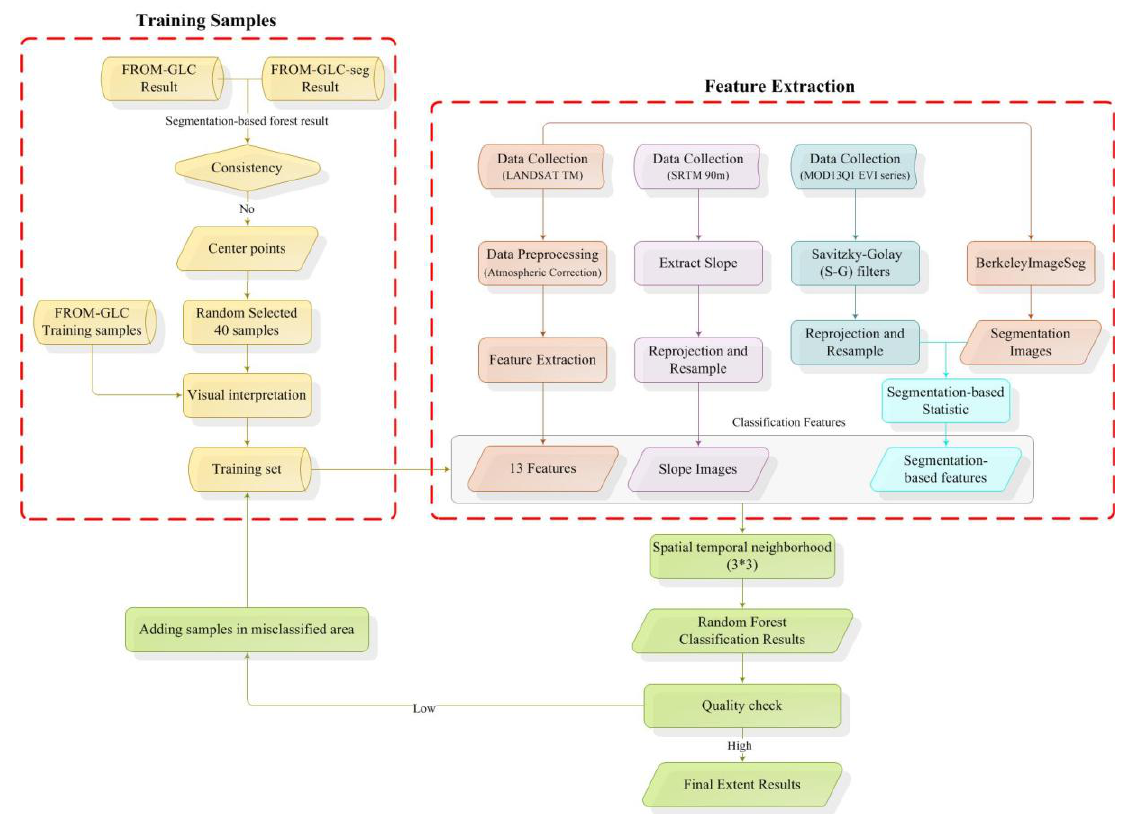
Figure 2. The workflow for forest/non-forest